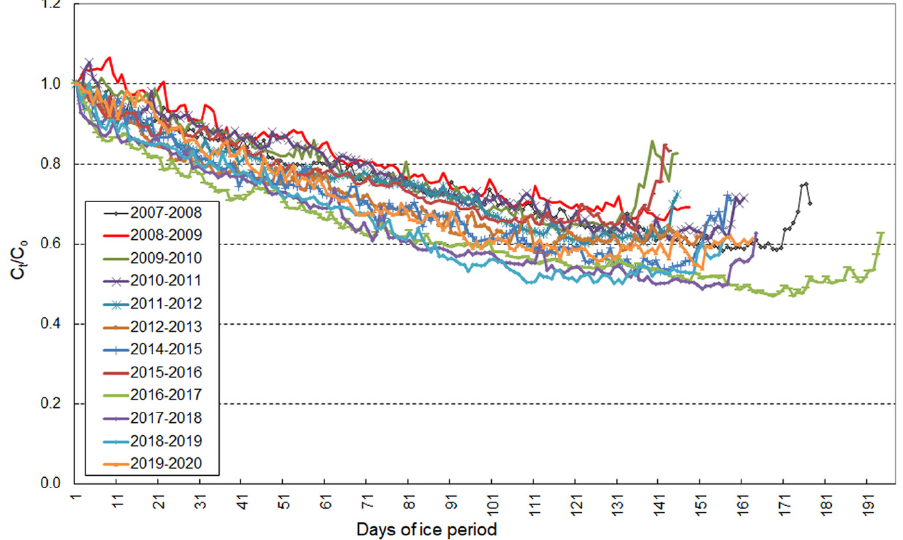
Figure 7. The value of C t /C 0_MIN at the end of the winter as a function of ice-on dates ( a ), and bottom water temperature at the end of the winter ( b ).